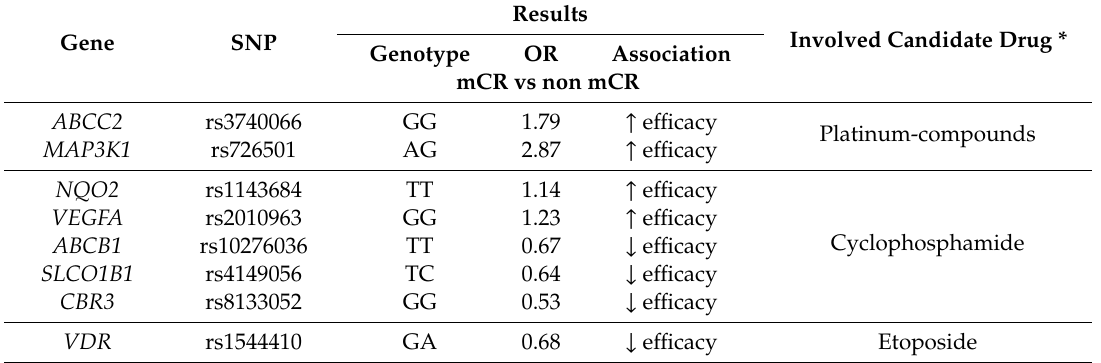
Table 2. SNPs related to Response to Induction Therapy, Rapid COJEC in High-Risk NB.